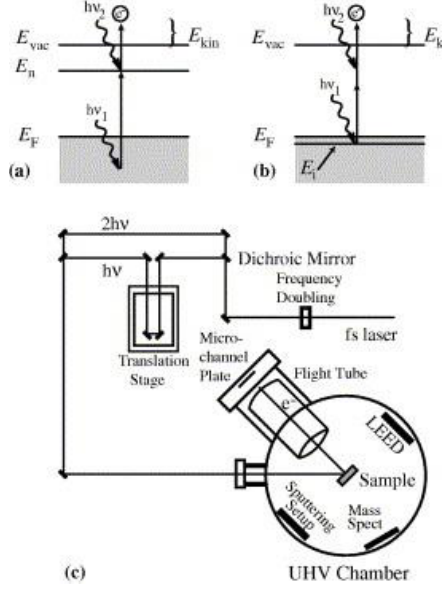
Figure 10. The Two-Photon Photoemission (2PPE) process. ( a ) Energy diagram for 2PPE of an unoccupied initial interfacial state. Absorption of photon 1 helps populate an excited intermediate state with a hot carrier and the absorption of photon 2 provides additional energy for the hot carrier to escape above the vacuum energy level. ( b ) The 2PPE process applied for an initially occupied interfacial state. ( c ) Schematic of the 2PPE experimental apparatus using a tunable femtosecond laser. Reprinted with permission from Ref [159] Copyright Elsevier (2005).